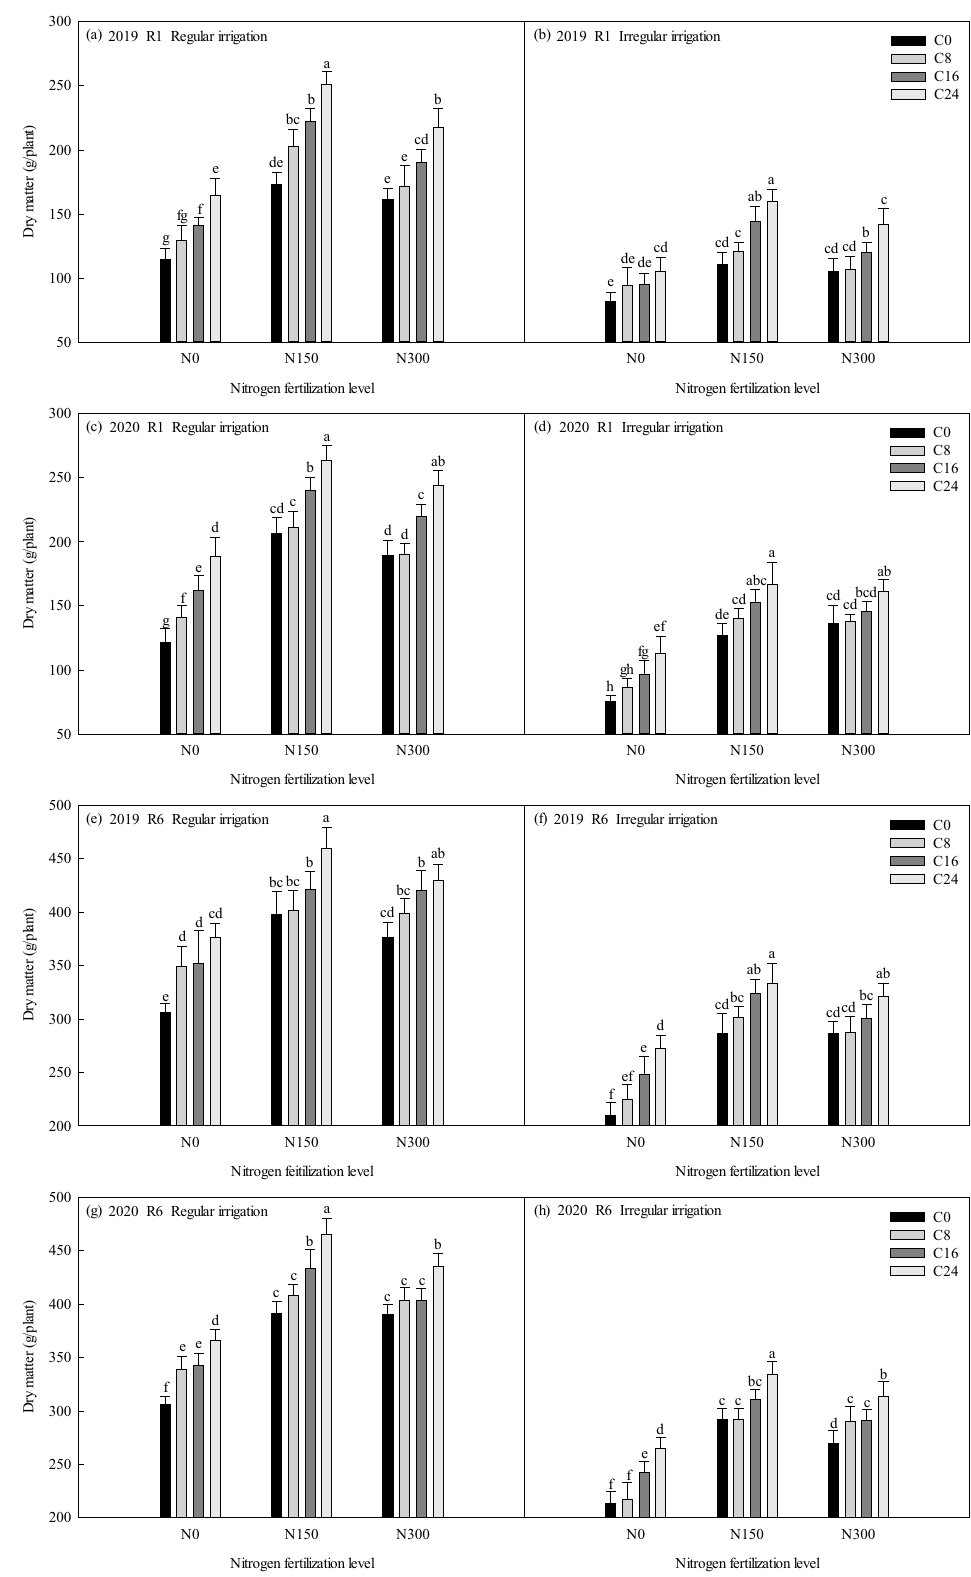
Figure 4. Effects of bio-char and nitrogen fertilizer on dry matter of maize under different irrigation